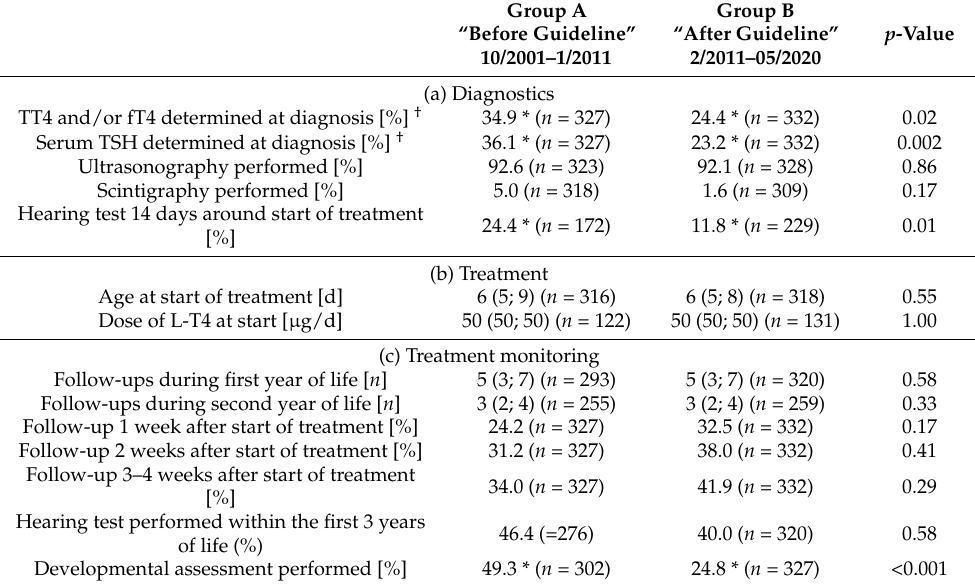
Table 4. Description and comparison of both groups according to the guideline